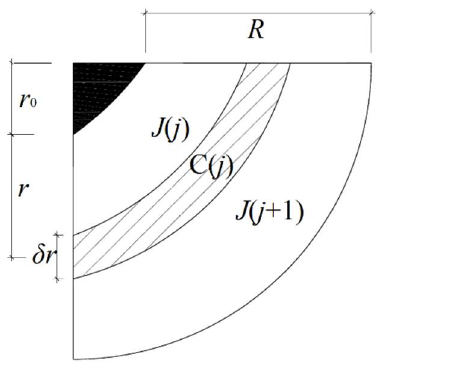
Table 1. Parameters for the multiple ionic transport model.